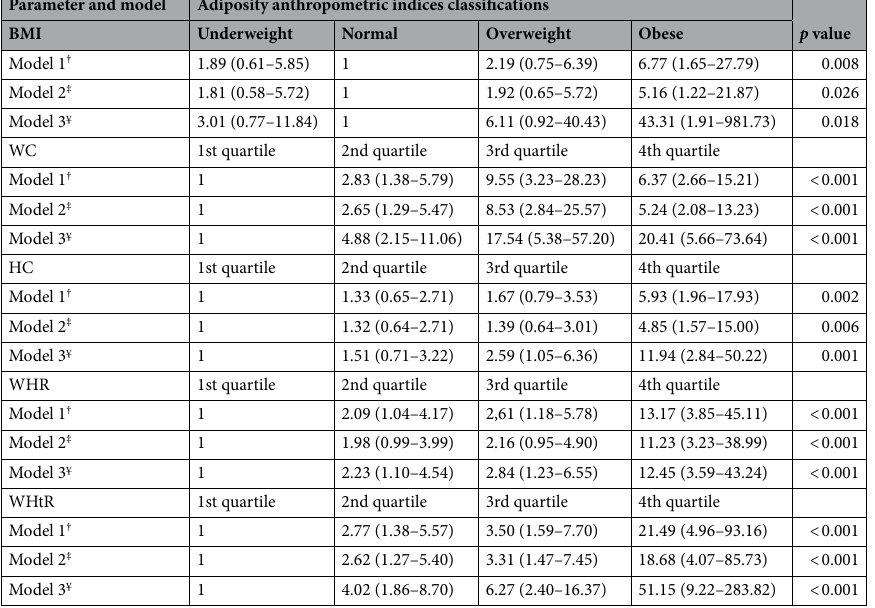
Table 2. Regression analysis showing the associations of BMI, WC, HC, WHR and WHtR with VF levels in diabetic patients. † Unadjusted. ‡ Adjusted for SBP and DBP. ұ Adjusted for gender, age, weight, height and FPS. 1: reference.